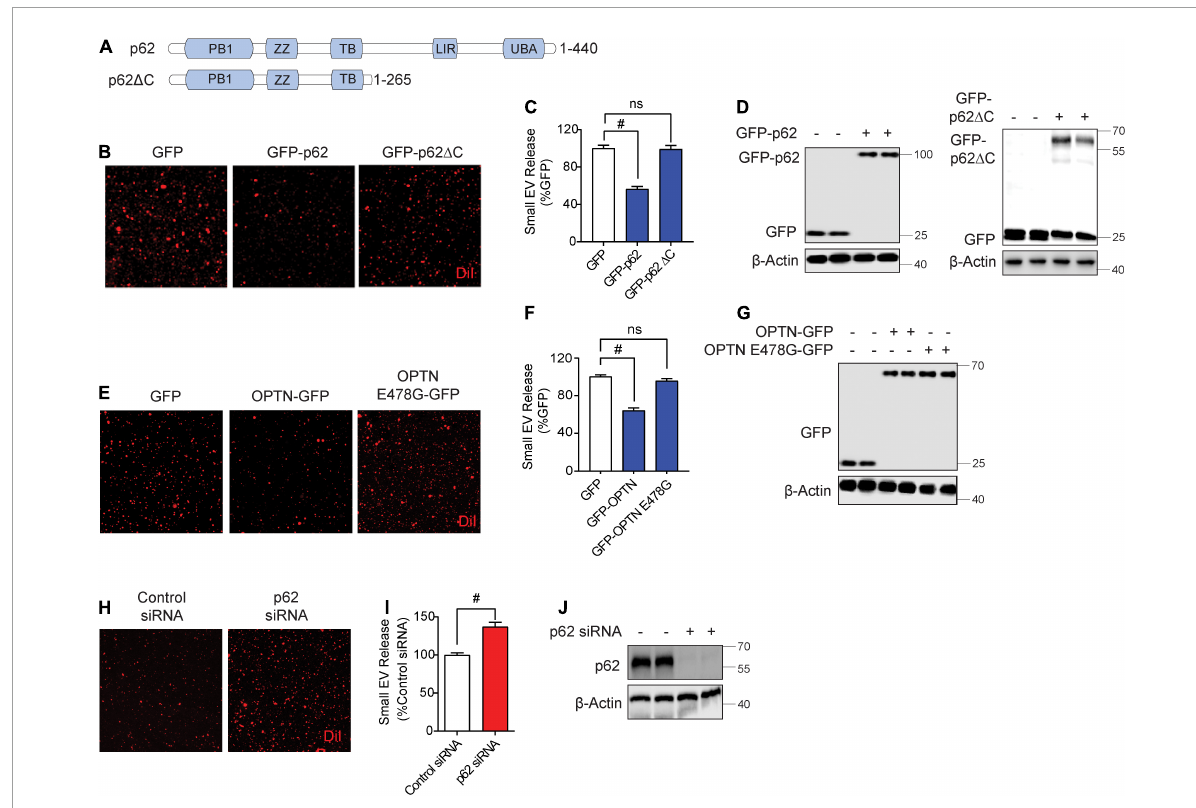
FIGURE2 Autophagy cargo receptors, p62 and optineurin, inhibit small EV secretion through the ubiquitin association domain. (A) Schematic of p62 full length and p62 (cid:49) C proteins with their respective domains. (B) Representative images of DiI-stained small EVs secreted from NIH3T3 cells expressing GFP, GFP-p62, or GFP-p62 (cid:49) C. (C) Quantification of secreted small EVs for (B) . Data are presented as means ± SEM. n = 3 independent experiments, 1-way ANOVA, followed by Dunnett’s post-hoc , # P < 0.0001. (D) Representative immunoblots of GFP-p62, GFP-p62 (cid:49) C, GFP, and β -Actin protein levels in lysates from cells for (B) . (E) Representative images of DiI-stained small EVs secreted from NIH3T3 cells expressing GFP, GFP-OPTN, or GFP-OPTN E478G. (F) Quantification of secreted small EVs for (E) . Data are presented as means ± SEM. n = 3 independent experiments, 1-way ANOVA, followed by Dunnett’s post-hoc , # P < 0.0001. n.s. = not significant. (G) Representative immunoblots for GFP, GFP-OPTN, and β -Actin protein levels in cell lysates for (E) . (H) Representative images of DiI-stained small EVs secreted from NIH3T3 cells transfected with control siRNA or p62 siRNA. (I) Quantification of secreted small EVs for (H) . Data are presented as means ± SEM. n = 4 independent experiments, t -test, # P < 0.0001. (J) Representative immunoblots for p62 and β -Actin protein levels in cell lysates for (H)